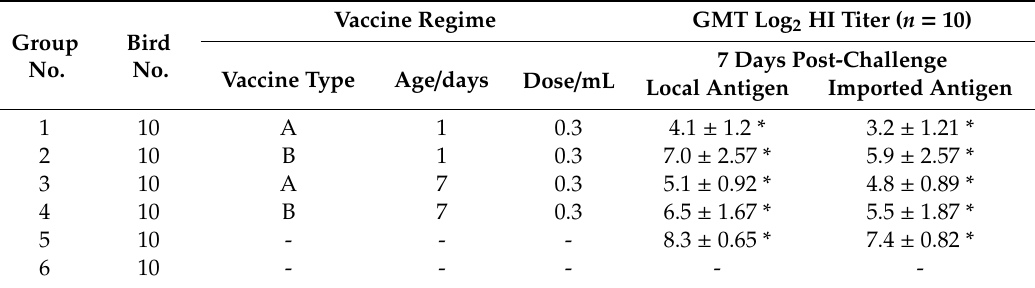
Table 5. The seroconversion at 7-DPC (days post-challenge) with recent Middle East H9N2 virus with two types of AIV-H9 antigen.